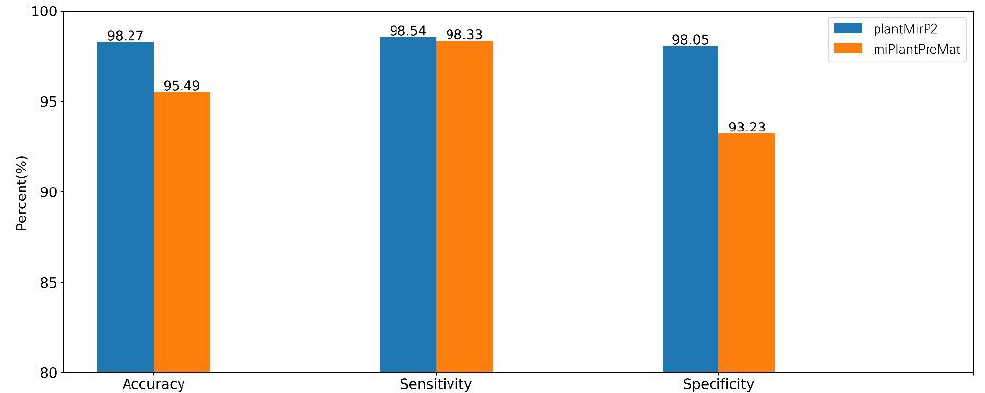
Figure 9. Based on the same dataset of miPlantPreMat, indicators of miPlantPreMat and plantMirP2 were compared.